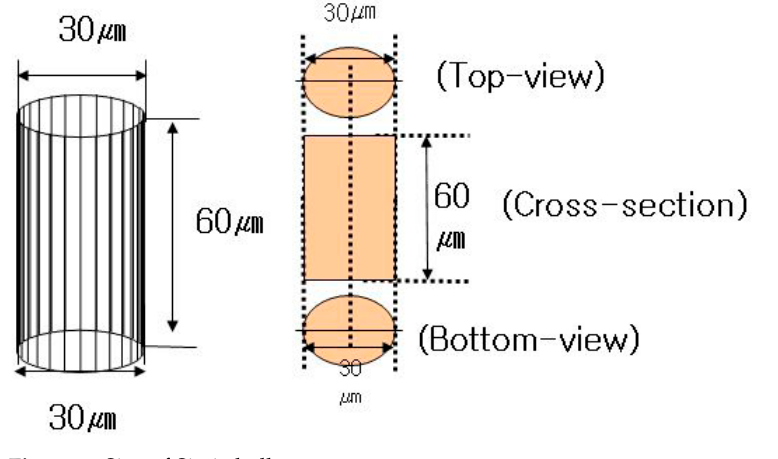
Figure 2. Size of Si via hall.